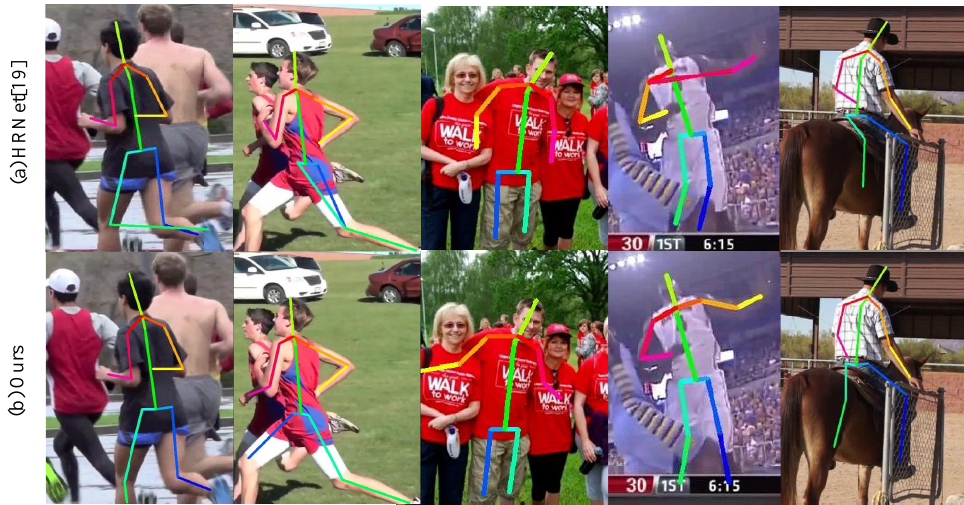
Figure 7. Qualitative comparison on the MPII dataset. HRNet (first row) often fails on overlapping and occluded joints in cluttered scenes. Our approach (second row) overcomes these limitations with dynamic information transfer.